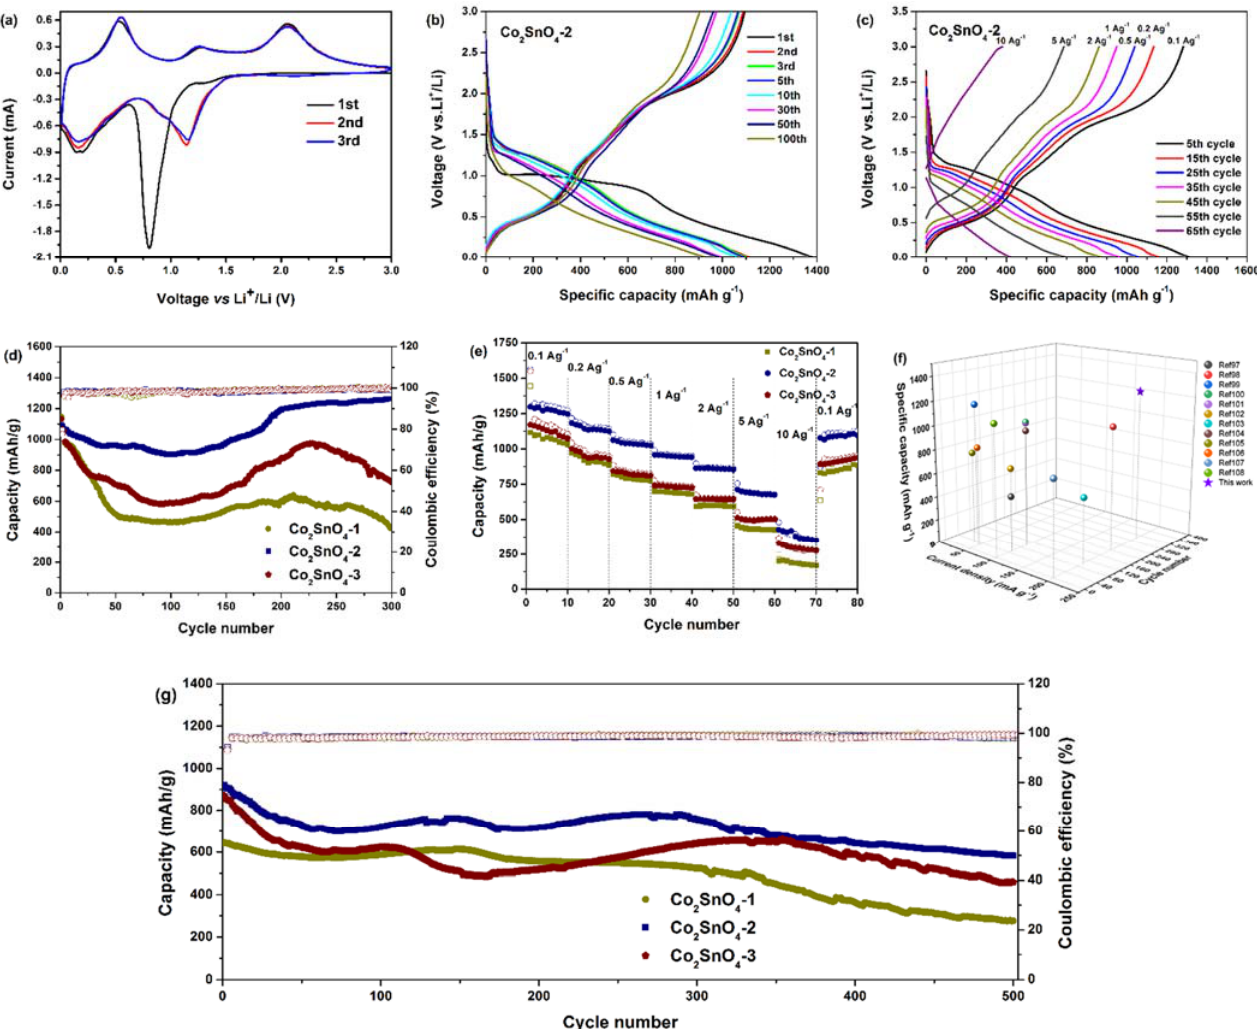
Figure 6. Lithium storage performance of Co 2 SnO 4 -2 anode: ( a ) CV profiles at 0.1 mV · s − 1 , ( b ) the first, second, third, fifth, tenth, thirtieth, fiftieth, and hundredth galvanostatic charge/discharge profiles at 200 mA · g − 1 , ( c ) rate performance. Lithium storage performance of different anodes: ( d ) Cycling stability at 200 mA · g − 1 and ( e ) rate performance. ( f ) Electrochemical performances comparison between tin-based and cobalt-based oxides anodes with different methods and components. ( g ) Long cycling performance of Co 2 SnO 4 anodes at 1.0 A · g − 1 for 500 cycles.